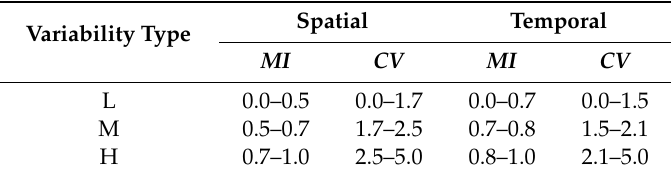
Table 3. Classification of spatial and temporal variability.